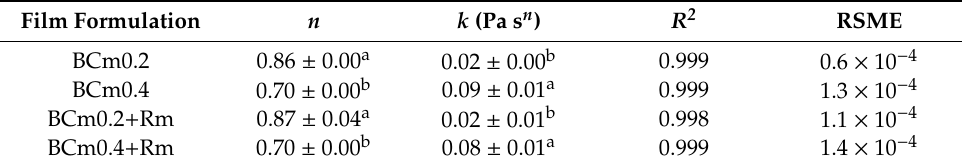
Table 6. Rheological parameters of Herschel–Bulkley model for BCm-based filmogenic solutions. Film Formulation